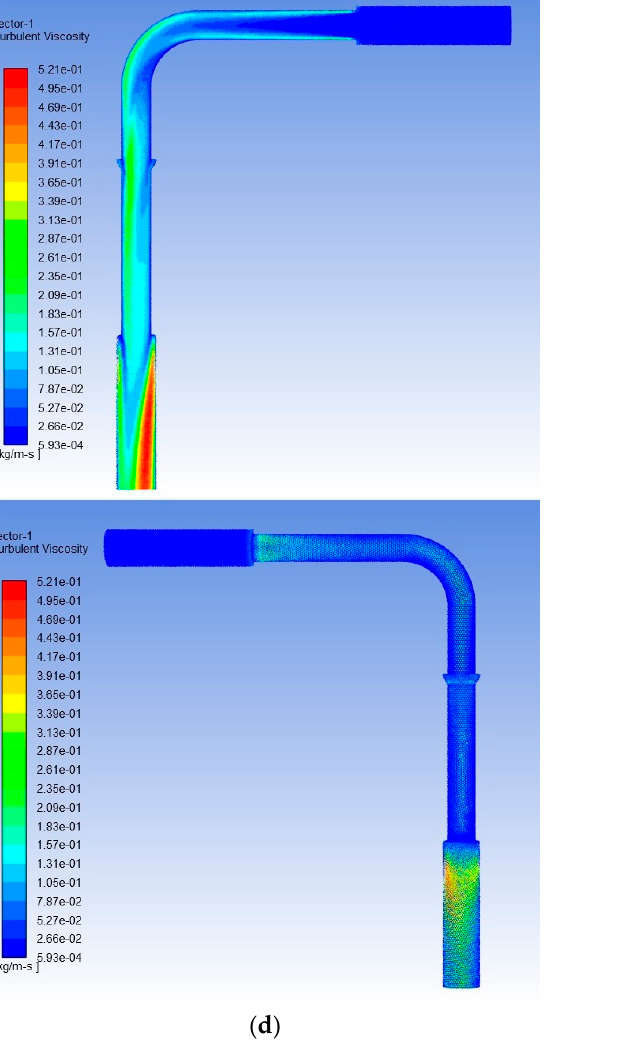
after fitting connection; ∆ p —pressure drop; ρ —fluid